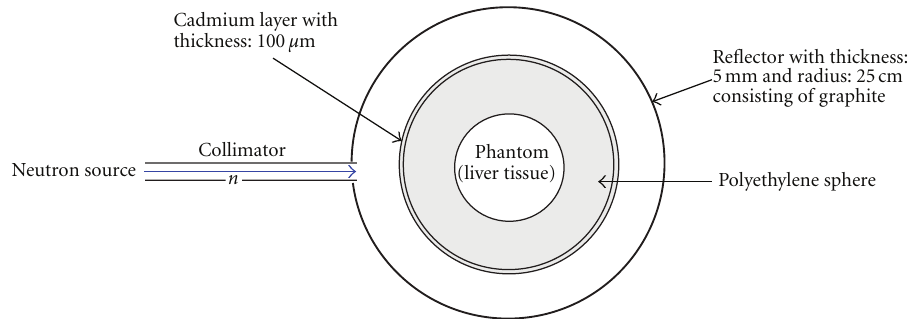
Figure 2: The sphere including the liver tissue for the neutron capture therapy.